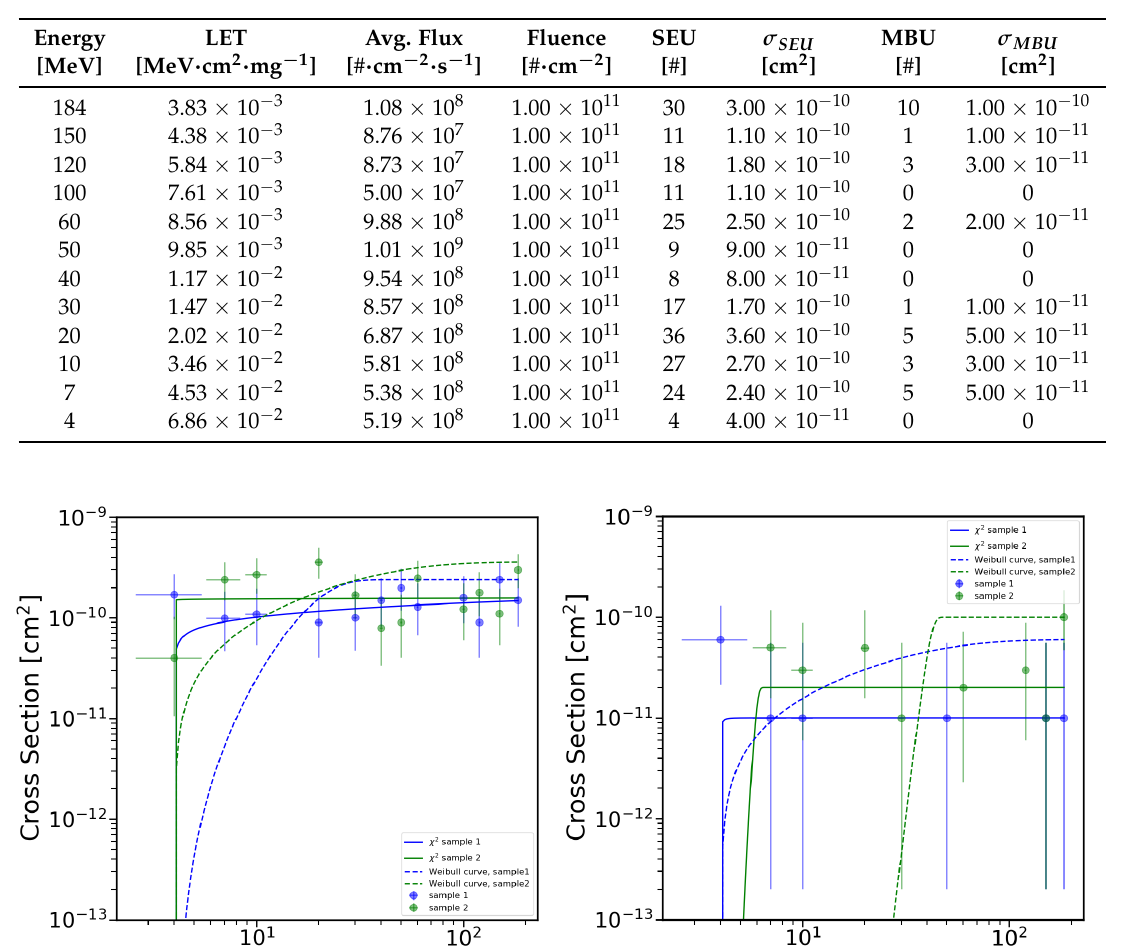
Table 5. SEU and MBU rate for DUT Sample 2.